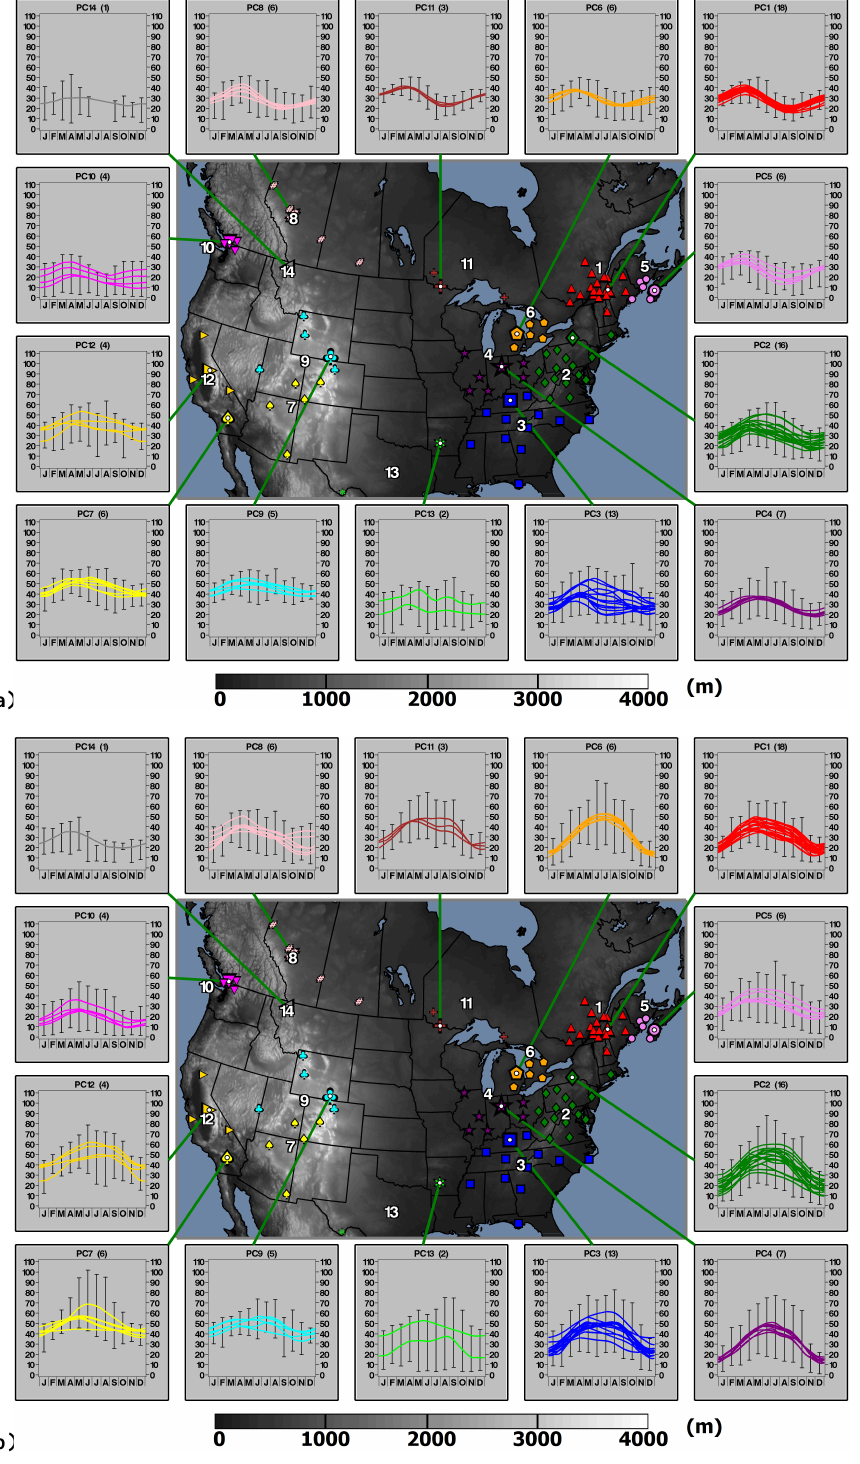
Fig. 5. (a) : Seasonal ozone variations generated by LOWESS (see text) associated with the baseline air trajectory clusters for all 97 sites. The error bars show the monthly ensemble site 5th to 95th percentiles for the region. The regional groupings are based on rotated PCA for JJA months. Elevations (above sea level, metres) are shown in gray scale from dark to light to represent low to high elevations. Elevations have been normalized to have a minimum of zero metre. (b) : Seasonal ozone variations associated with the most polluted air trajectory clusters for all 97 sites. Vertical axes represent ozone mixing ratios (ppb) and the tickmarks on the horizontal axes represent the start of each